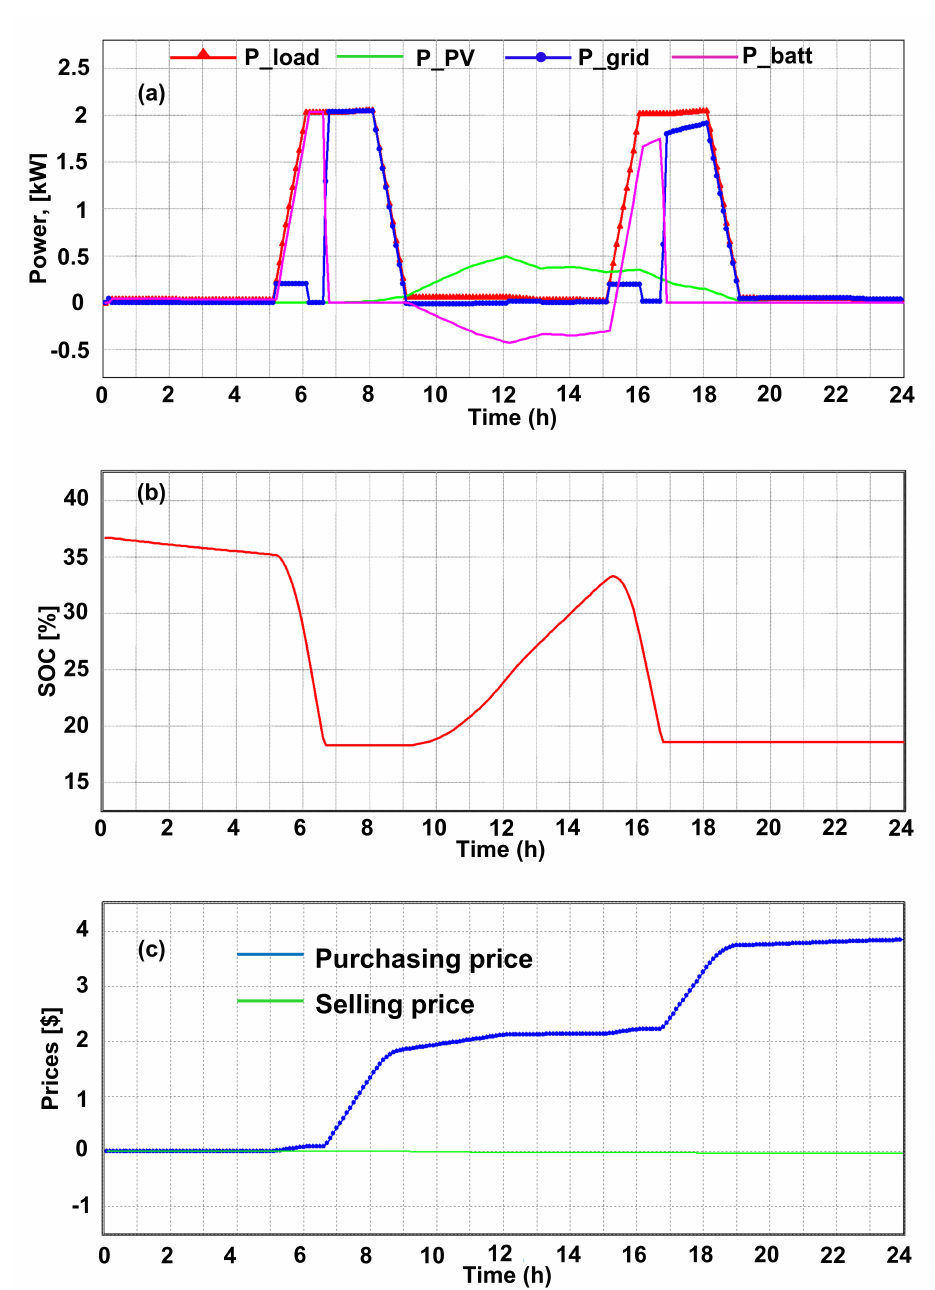
Figure 7. Power flow in a cloudy winter: ( a ) PV output power, grid, battery power, and power demand; ( b ) State of charge; ( c )